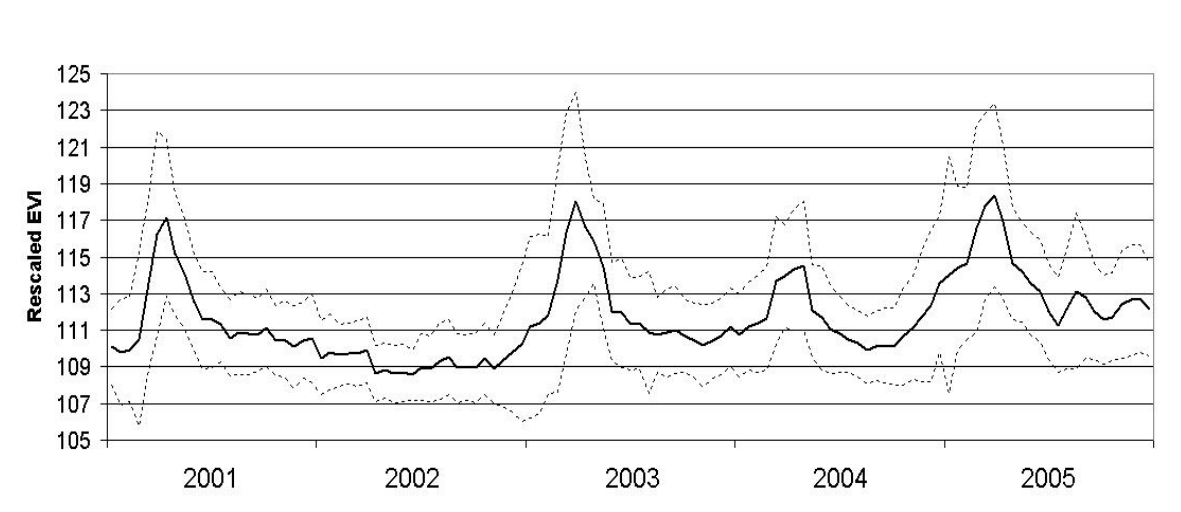
Figure 4. Profile of the average MODIS-EVI for all 50 field-sites at each MODIS composite time period during 2001 - 2005 (23 per year). Solid line shows Mean of 50 sites, with dashed lines defining +/- 1 Standard